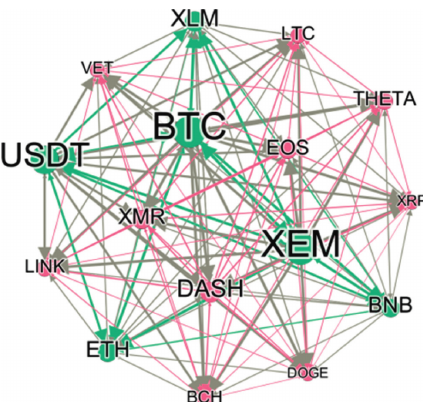
Figure 38: Risk spillover under